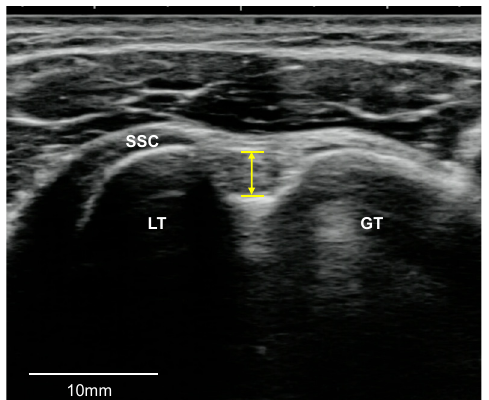
Figure 1. The measurement of the biceps tendon thickness. SSC, subscapularis tendon; GT, greater tuberosity; LT, lesser tuberosity.